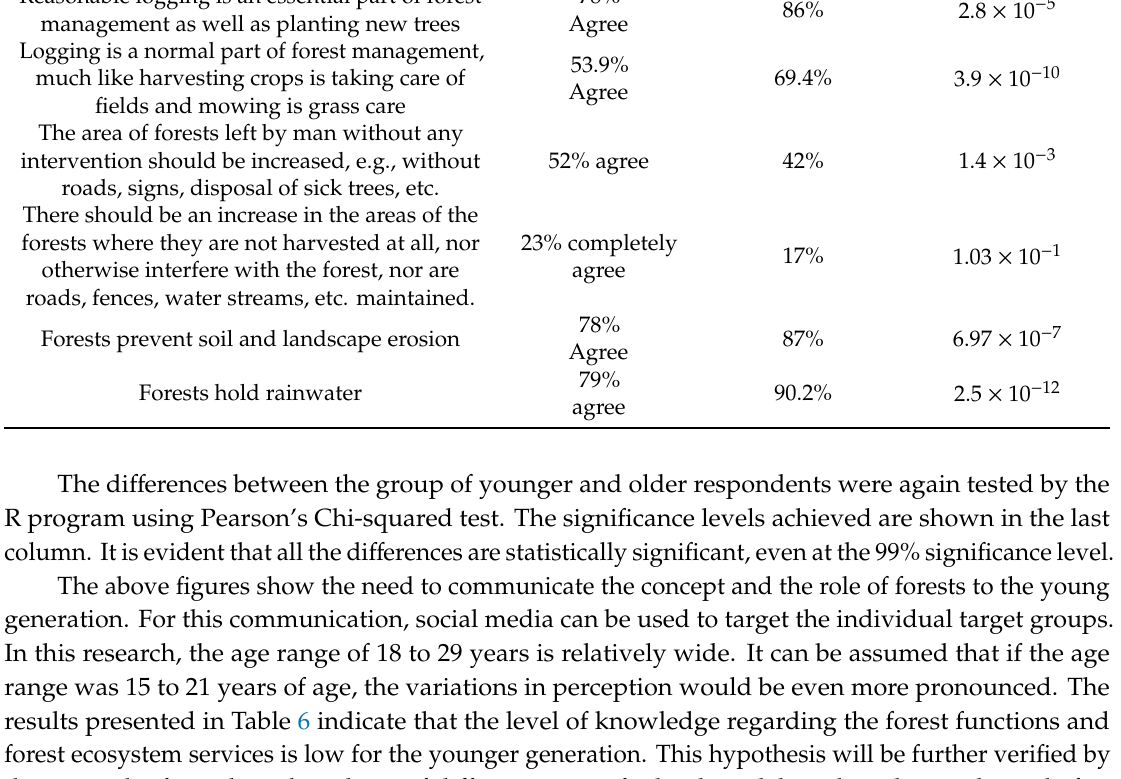
The Whole Population 86%